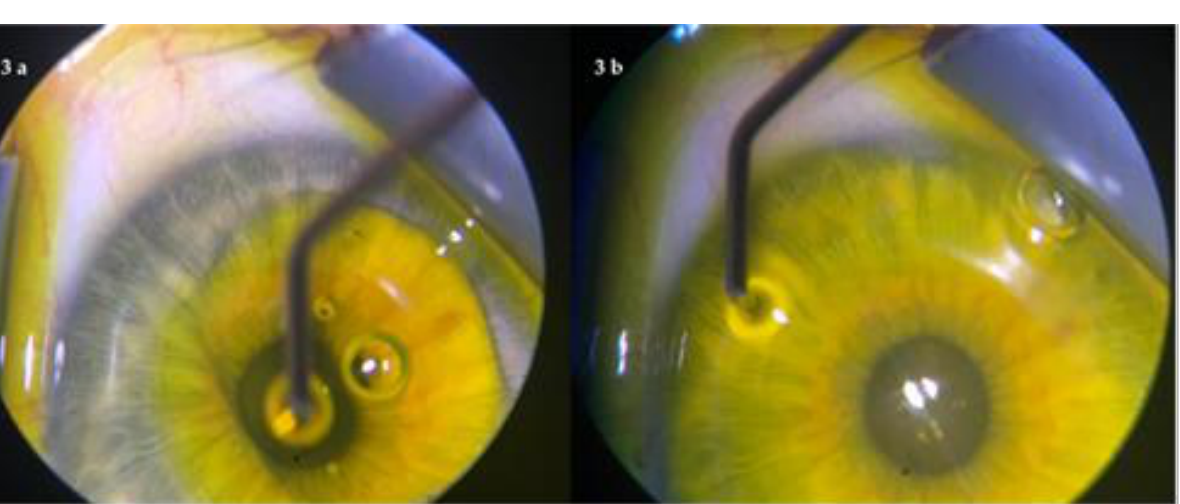
Table 2. Chemically-boosted ACXL (CB-ACXL) using SafeCross ®